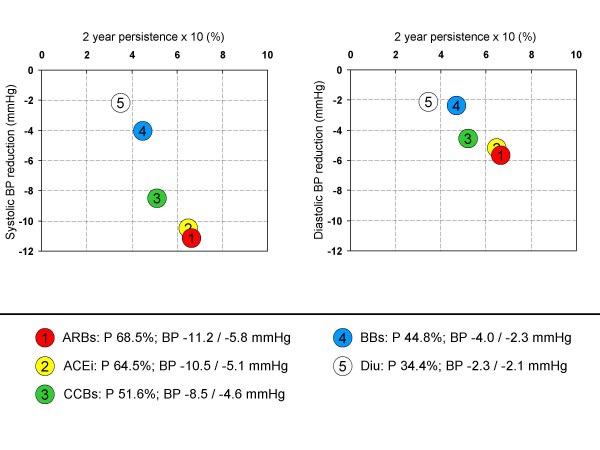
Blood pressure reduction vs. 2 year persistence with treatment. Mean blood pressure reduction and persistence with treatment over 2 years was taken from Veronesi [19].